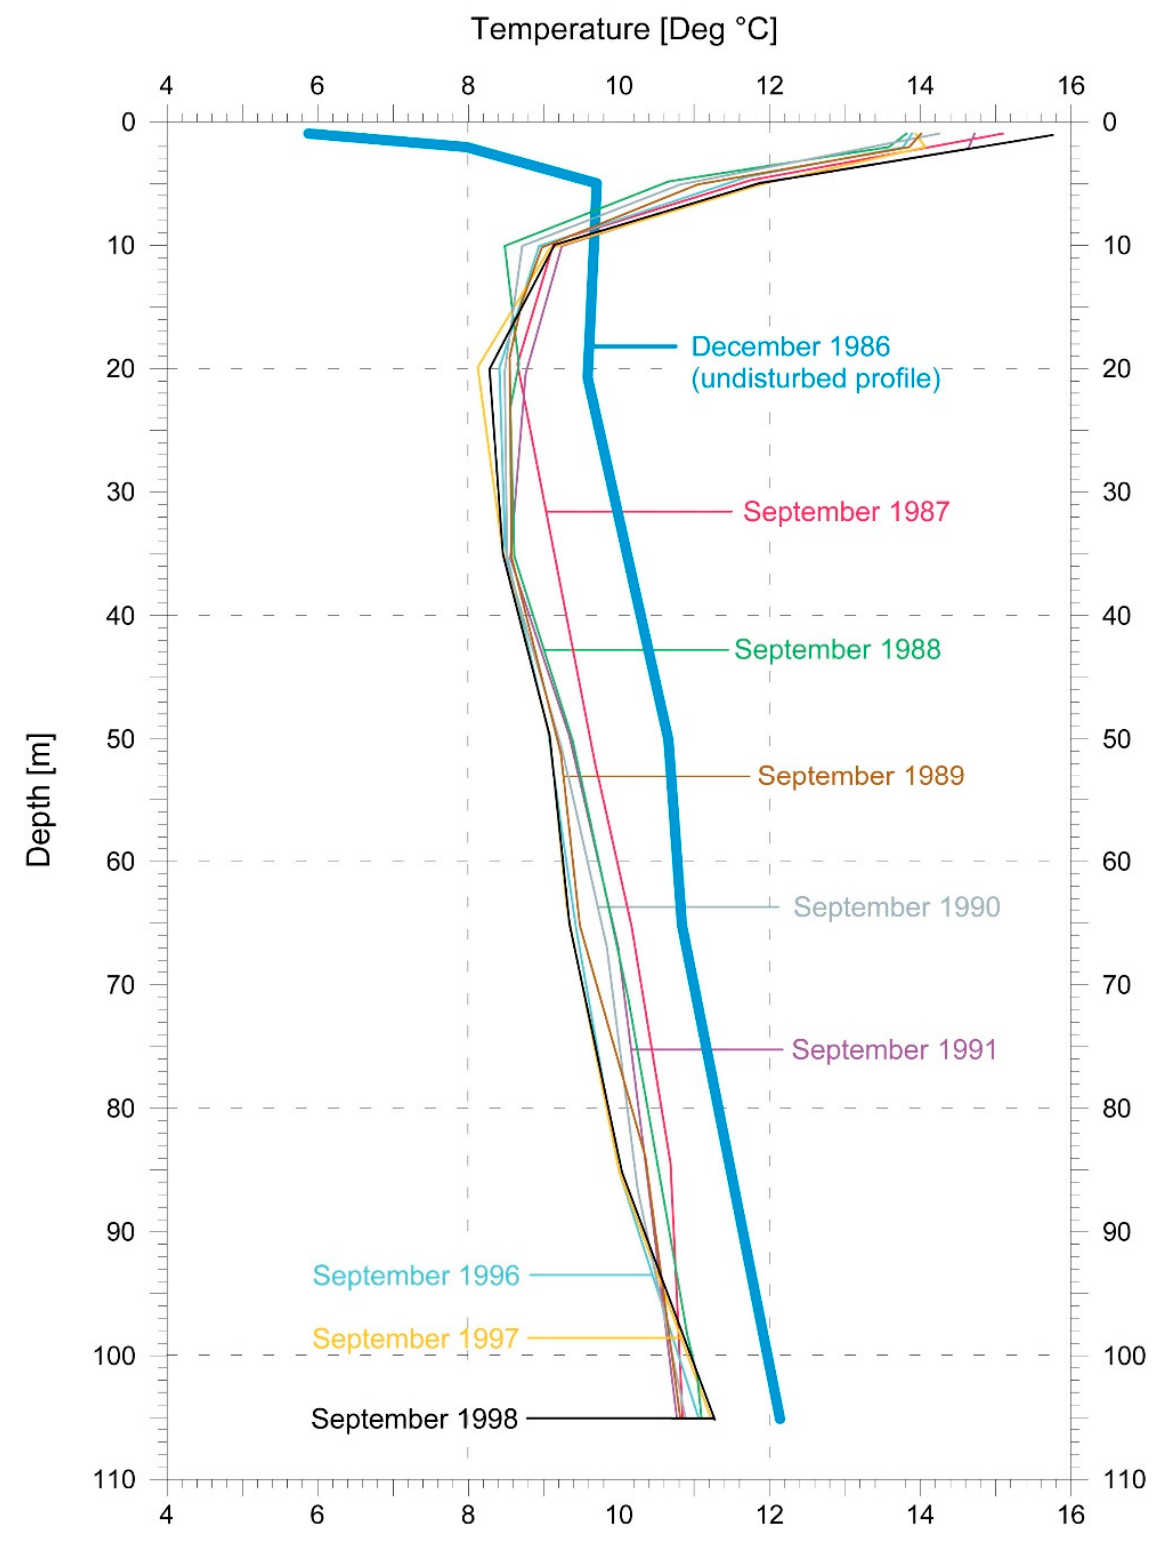
Figure 5. Measured ground temperature profiles, including those in the second campaign (from 1996 to 1998) at a distance of 0.5 m from the BHE in Elgg. Data from [5] are plotted.